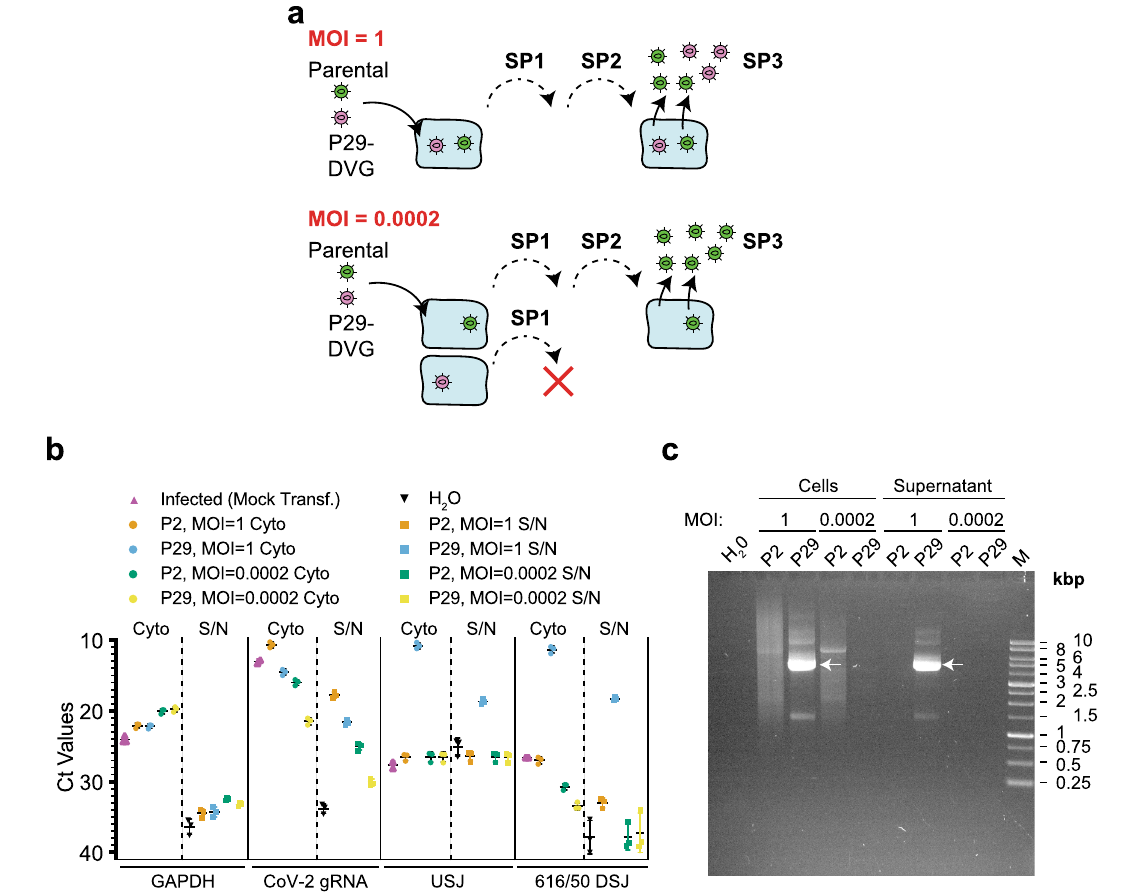
Fig. 2 Replication of SARS-CoV-2 DVGs is helper virus-dependent. a Schematic diagram showing DVG-dependency on parental virus for replication and propagation. At an MOI = 1, both parental and DI genomes are expected to be maintained upon serial passage. At low MOI (0.0002) in which parental genomes and DIs enter different cells, the DI will be lost upon sequential serial passaging. b RT-qPCR analysis of RNA isolated from cells or supernatant infected with the indicated viral passages and MOI. n = 3 biologically independent experiments ± SD. c Isolation of DIs from Vero cell lysates and media that had been infected with the indicated viral stocks at an MOI of 1 or 0.0002. Ampli fi cations were performed using A1 and A2 primers for 30 cycles. Products were analyzed on a 0.8% agarose/TAE gel. White arrows indicate recovery of 5 kb DVGs. M; 1 kb DNA